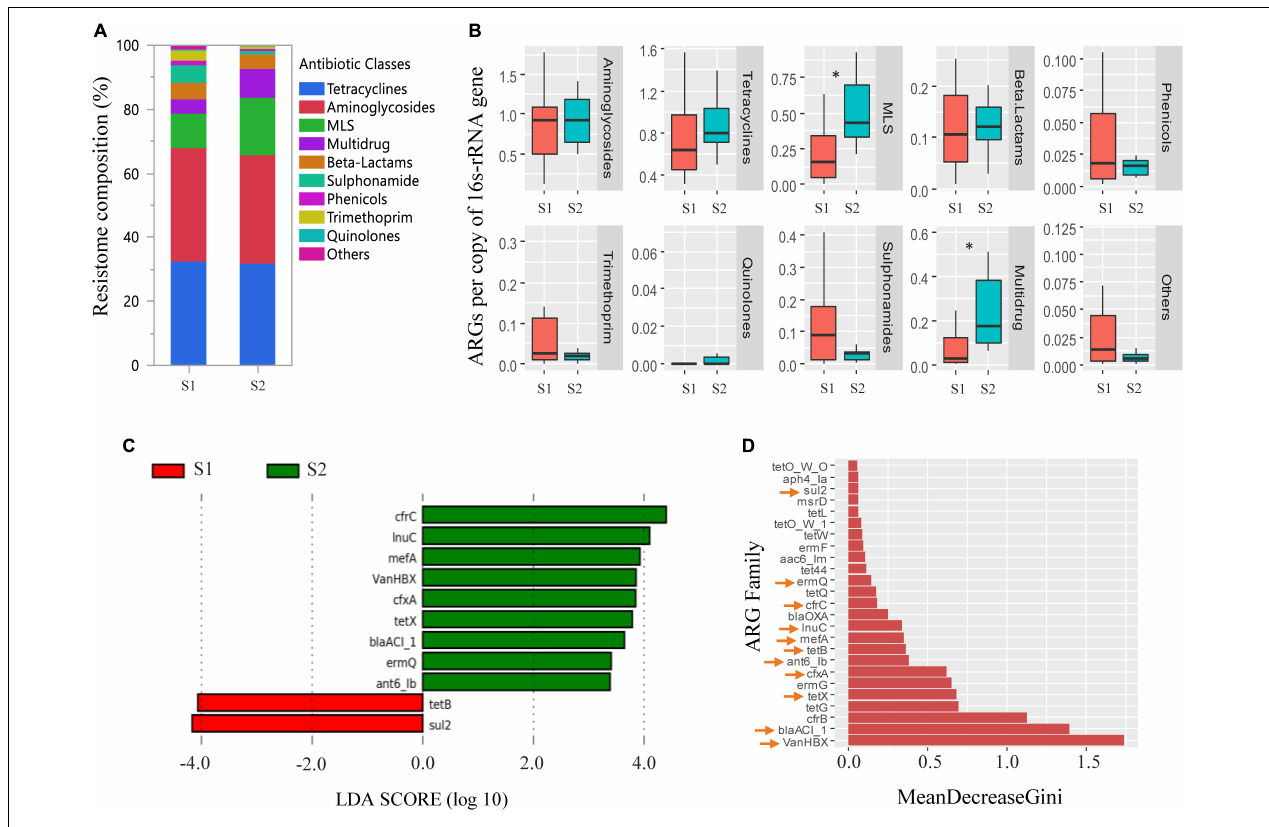
FIGURE 4 | Antimicrobial resistance genes (ARGs) in feces collected from veal calves soon after they were brought onto the farms (Sampling 1/S1, n = 12) and fecal samples from the same cohort of calves at slaughter-age (Sampling 2/S2, n = 12). (A,B) Compare relative abundances of ARG classes in feces taken from calves at S1, S2. Antimicrobial classes: Fosfomycins, Polymyxins, and Glycopeptides constituted the “Others” group. (C) Differentially abundant ARGs in feces taken from calves at S1, S2 using linear discriminant analysis coupled with effect size measurements (LEfSe). (D) Differentially abundant ARGs in feces taken from calves at S1, S2 using randomForest. ARGs with an arrow are the ARGs that were found to be differentially abundant between the two samplings using LEfSe analysis. Triple asterisks ( ∗∗∗ ) represent statistical significance with p < 0.001, double asterisks ( ∗∗ ) represent p < 0.01, a single asterisk ( ∗ ) represents p < 0.05, and no asterisk represents no statistical significance were